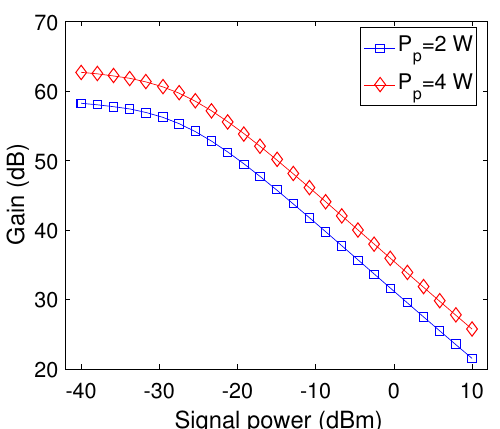
Figure 10. Signal power versus gain plots as a function of pump